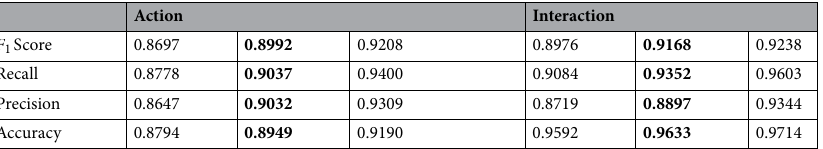
Table 2. Results of multi-output HAR model (full sensor configuration): first quartile, median value (bold font), and third quartile shown for both outputs.